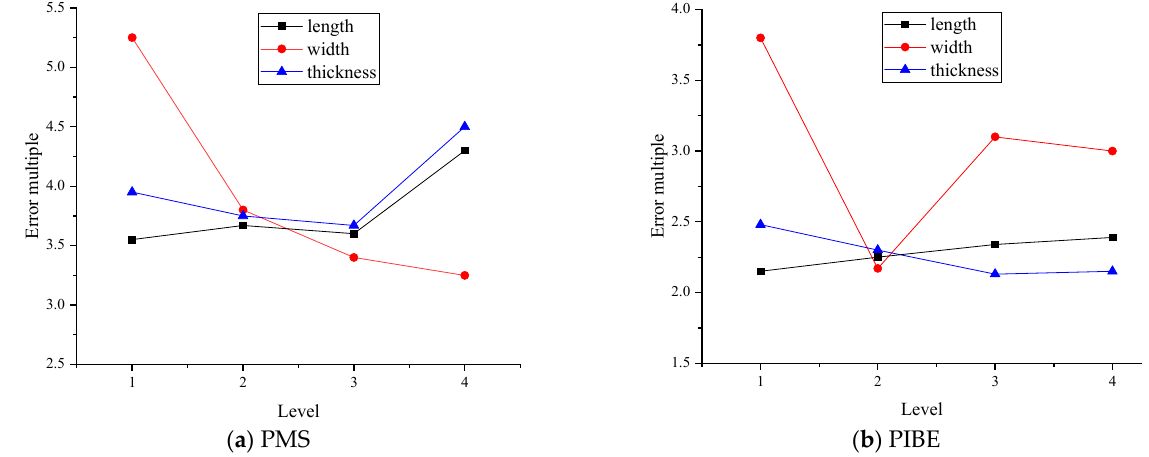
Figure 8. Analysis of resistance values of thin-film resistor grid geometry. The resistance strain coefficients of the thin-film resistance grid prepared by the two preparation methods are shown in Figure 9.